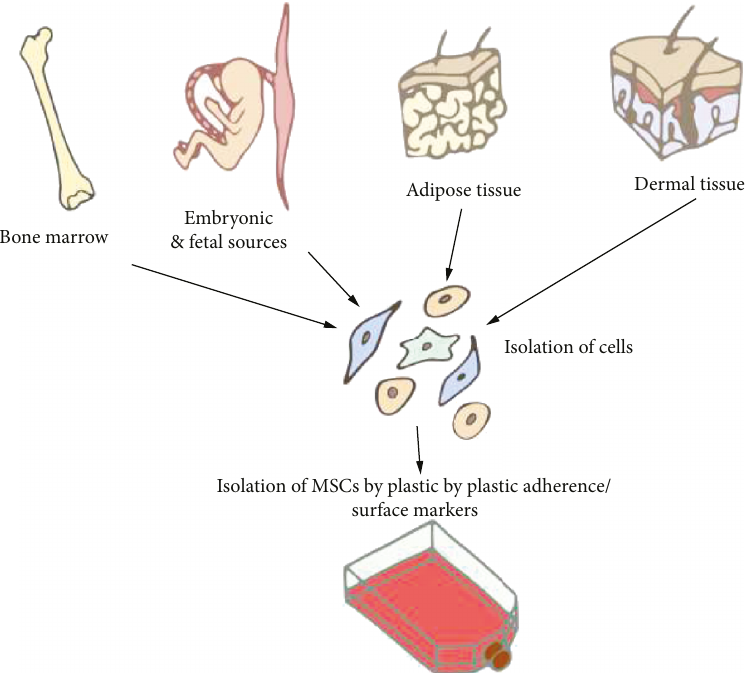
Figure 1: Mesenchymal stromal cells have been isolated from adult tissue including adipose tissue, dermal tissue, and bone marrow, as well as from embryonic and fetal sources. MSCs have been isolated from tissue by their ability to adhere to plastic or by their surface antigen expression (e.g., CD105 + , CD73 + , and CD90 + ).